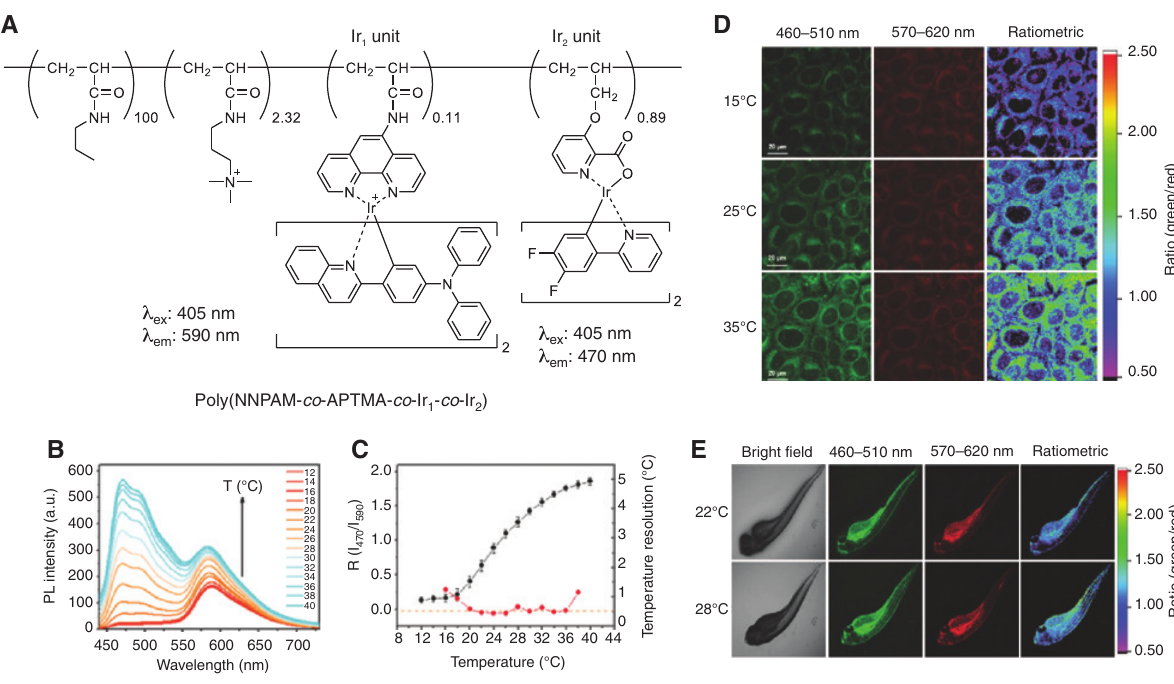
= 20,700, M = 10,100, M = 2.05). - co -Ir ) ( M / M 1 2 w n w n - co -Ir ). (B) Photoluminescence (PL) spectra of poly(NNPAM- co -APTMA- co -Ir - co -Ir ) 1 2 1 2 = 405 nm). (C) Temperature-dependent photoluminescence intensity ratio at 470 and 590 nm ex - co -Ir ) (left and center) and the corresponding ratiometric images 1 2 = 405 nm), and the cor- ex - co -Ir ). Reproduced 1 2